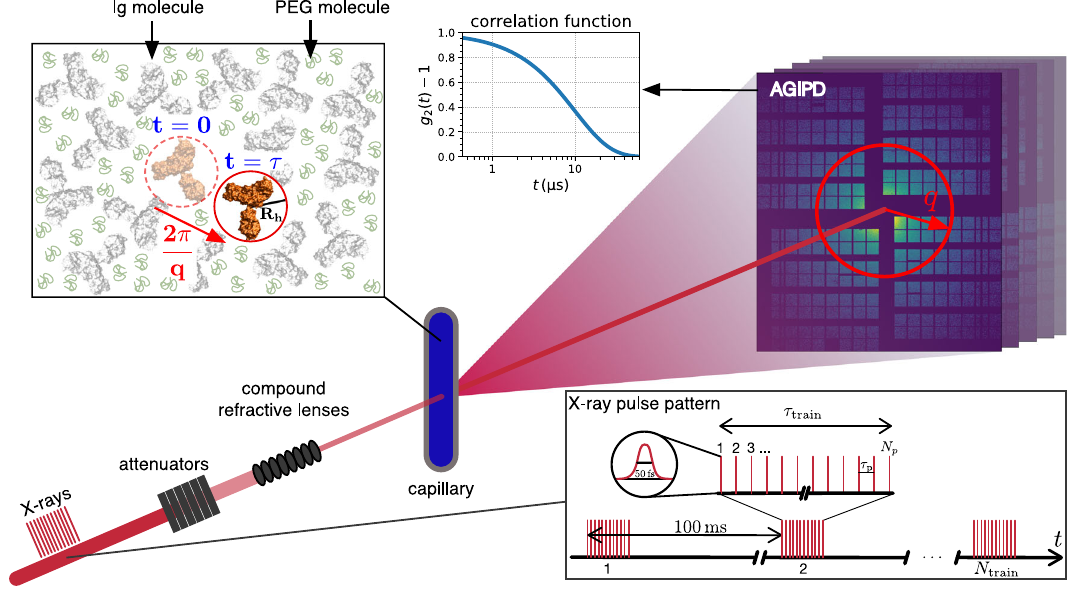
Fig. 1 | Scheme of the experiment. Highly concentrated solutions of immu- noglobulin (Ig) with polyethylene glycol (PEG) are measured in quartz capillaries. An individual Ig molecule has a hydrodynamic radius of R h =5.5nm. Megahertz X-ray photon correlation spectroscopy (MHz-XPCS) measurements are performed by using trains of X-ray pulses, which illuminate the sample. The spacing between two pulseswithina train is τ p and wasvaried between 443and 886ns whereatrain contains N p individual X-ray pulses. The length of an individual X-ray pulse is ≤ 50fs 50 . Anewtrain is delivered every 100ms. The trainduration isdeterminedby